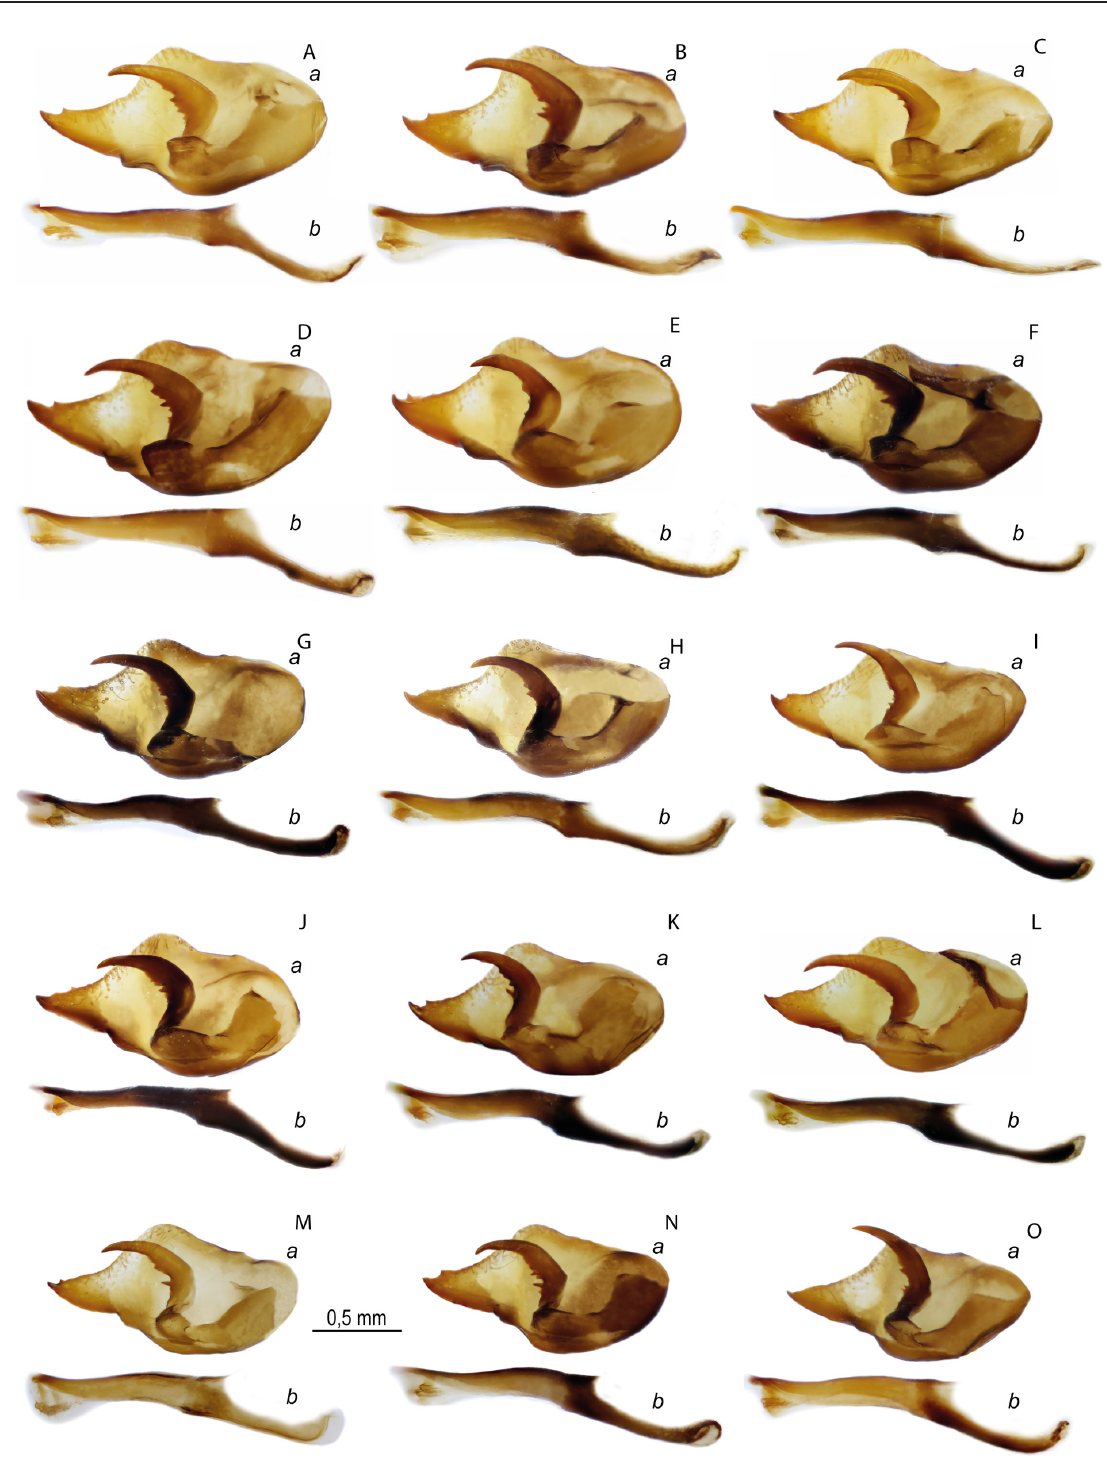
Fig. 10. Male genitalia (a = valva; b = aedeagus). A–F . Melitaea timandra timandra Coutsis